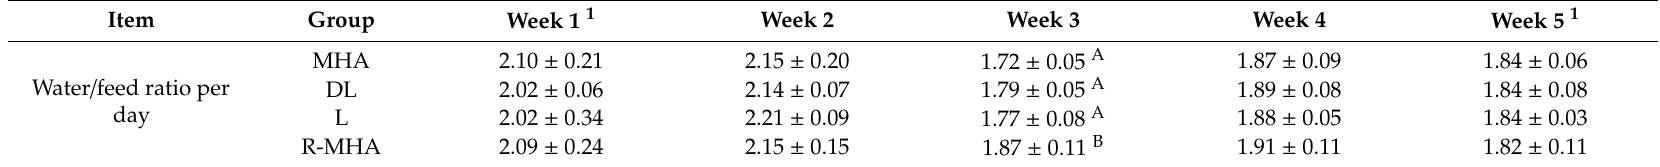
Table A2. Average of water / feed intake ratio per day and